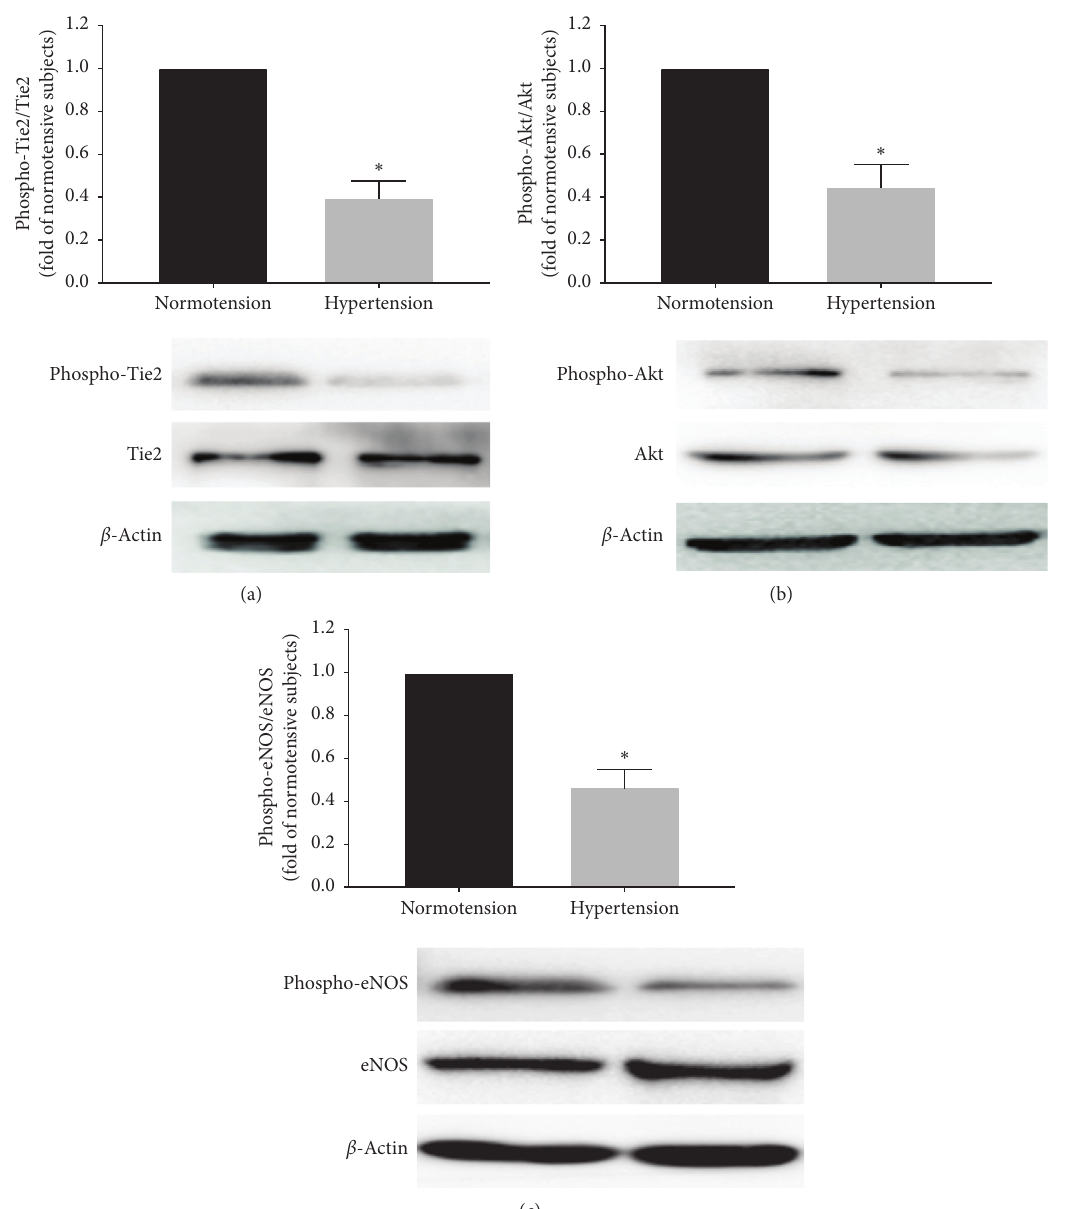
Figure 2: The quantification analysis of Tie2, Akt, and eNOS phosphorylation in human EPCs in the two groups. (a–c) Quantification analysis showing that the phosphorylation of Tie2, Akt, and eNOS in EPCs from patients with hypertension was significantly lower than that in EPCs from normotensive subjects ( ∗ P < 0 . 05 vs. EPCs from normotensive subjects, n � 18 per